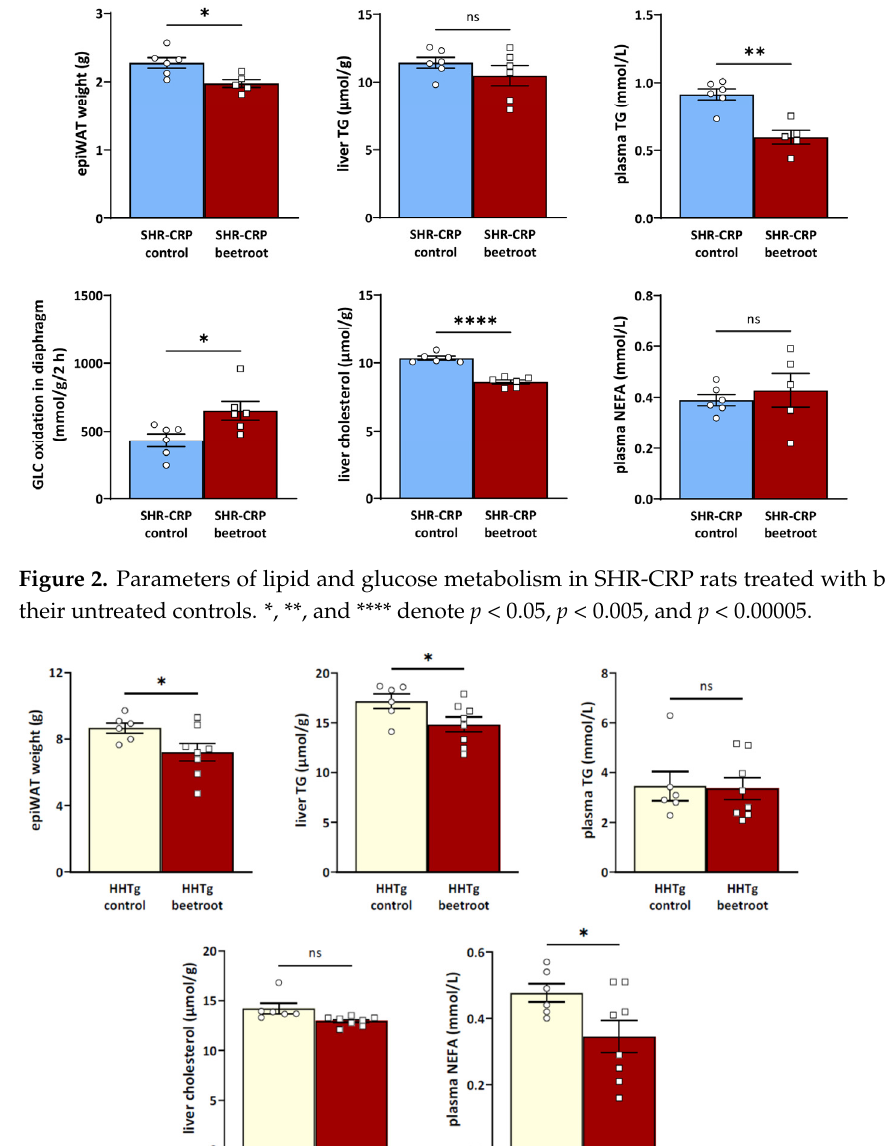
Table 2. Parameters of inflammation in serum.